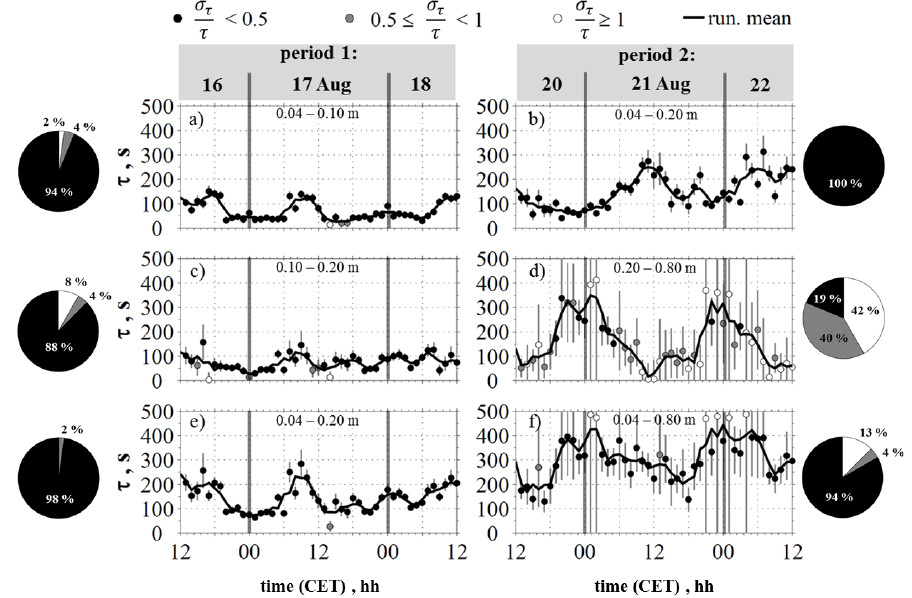
Fig. 9. Calculated transport times, τ , for three layers (lower a , b ; upper c , d ; and overall e , f ) classified according to the magnitude of the relative uncertainty for the two selected periods. The error bars represent the absolute uncertainty of τ determined using Gaussian error propagation (Eq. 4). The pie diagrams represent the percentage of τ in each quality class for the plots shown (black: good, grey: adequate, white: inadequate